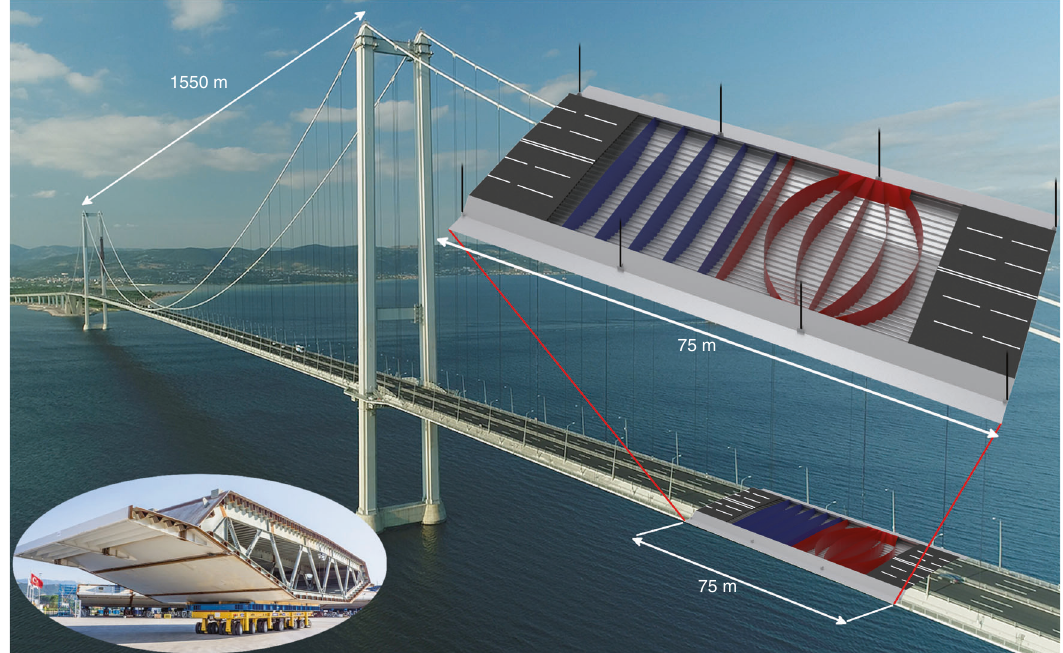
Fig. 1 Conventional and interpreted girder design. In the background, the Osman Gazi Bridge is shown with an indication of the main span of 1550 m. Insert in the lower left shows a conventional girder section of the Osman Gazi Bridge with truss diaphragms. In the upper right insert, three sections of the continuous girder are shown with solid diaphragms. The conventional design (blue) and the interpreted design (red), extracted from the optimization result, are shown in each of the two center sections, respectively. Here, the fi xed top layer is removed to reveal the internal